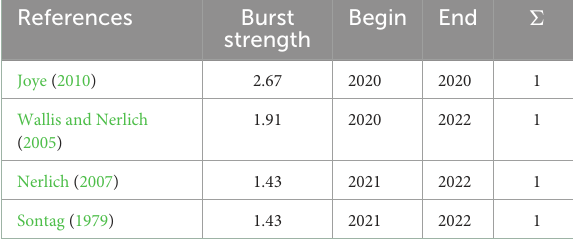
TABLE 5 Timespan citations of the citing